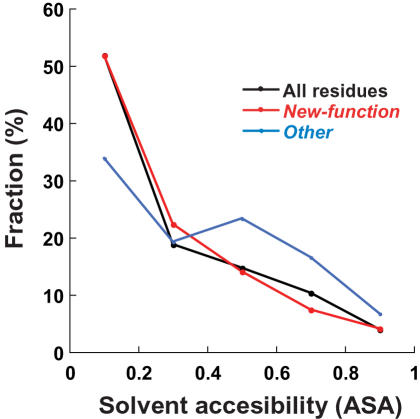
Solvent accessibility (ASA) of the mutated residues.ASA values were calculated with “ASA view” (http://www.netasa.org/asaview/). Plotted are the distributions for all protein residues, and residues in which new-function mutations, and other mutations occur.